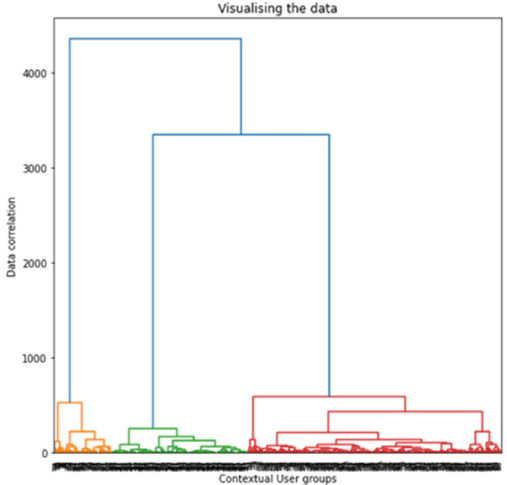
Figure 2. Dendrogram representation of first-level